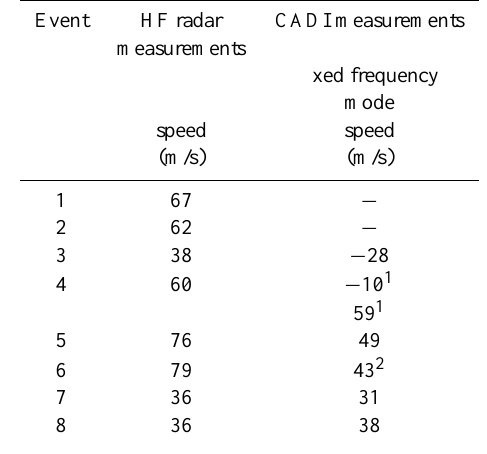
Table 2. Table of the 8 events comparing the drift measurements in the azimuthal (zonal or EW direction) from the ATI HF radar analysis to the fixed frequency mode